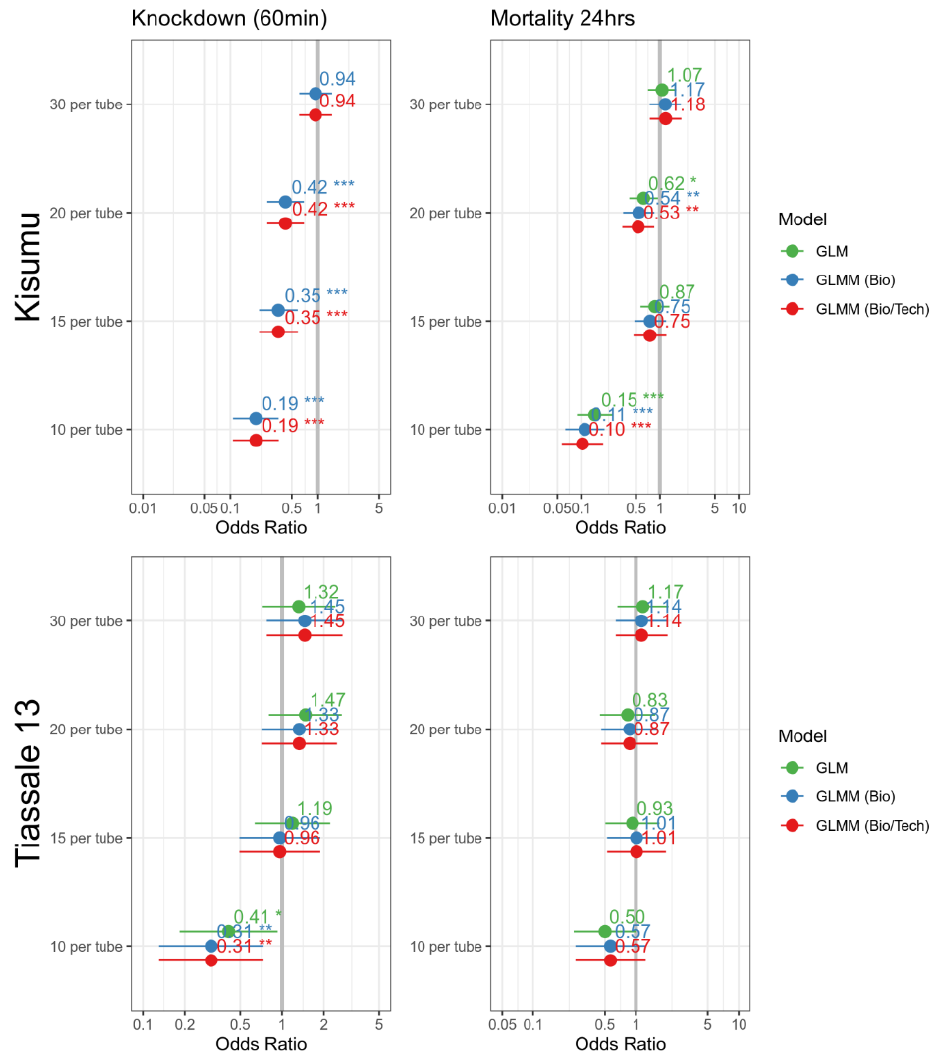
Figure A1. Odds ratio plot for the number of mosquitoes per test unit. The dataset was screened using a binomial GLM, binomial GLMM with random effect for biological replicate, and binomial GLMM with a random effect for biological replicate, and a nested random effect for technical replicate using the glmmTMB package in R. For this analysis, the variable was the age as a factor with 25 mosquitoes used as reference. P-value significance indicated by ‘*’ if ≤ 0.05, ‘**’ if ≤ 0.01 and ‘***’ if ≤ 0.001.